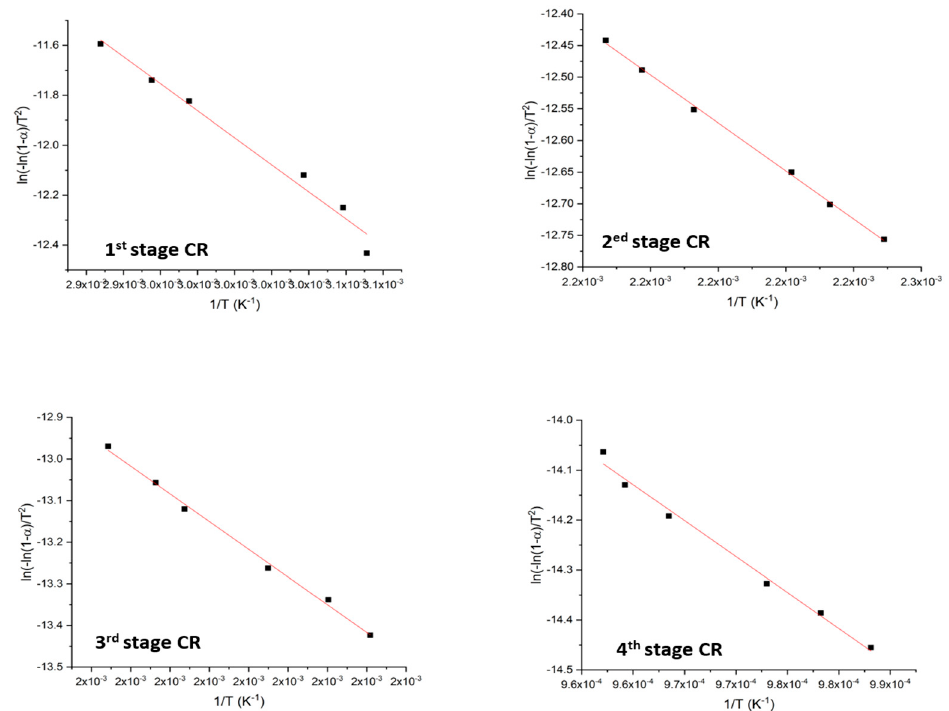
Figure 4. Coast–Redfern of Mn(II) in different stages. The negative values of ∆ S indicate pointed to high randomness-degree in non-spontaneous reaction. The positive values of ∆ G showed the reaction is non-spontaneous towards products and spontaneous towards the reactants and the positive values of ∆ H means the reaction is endothermic